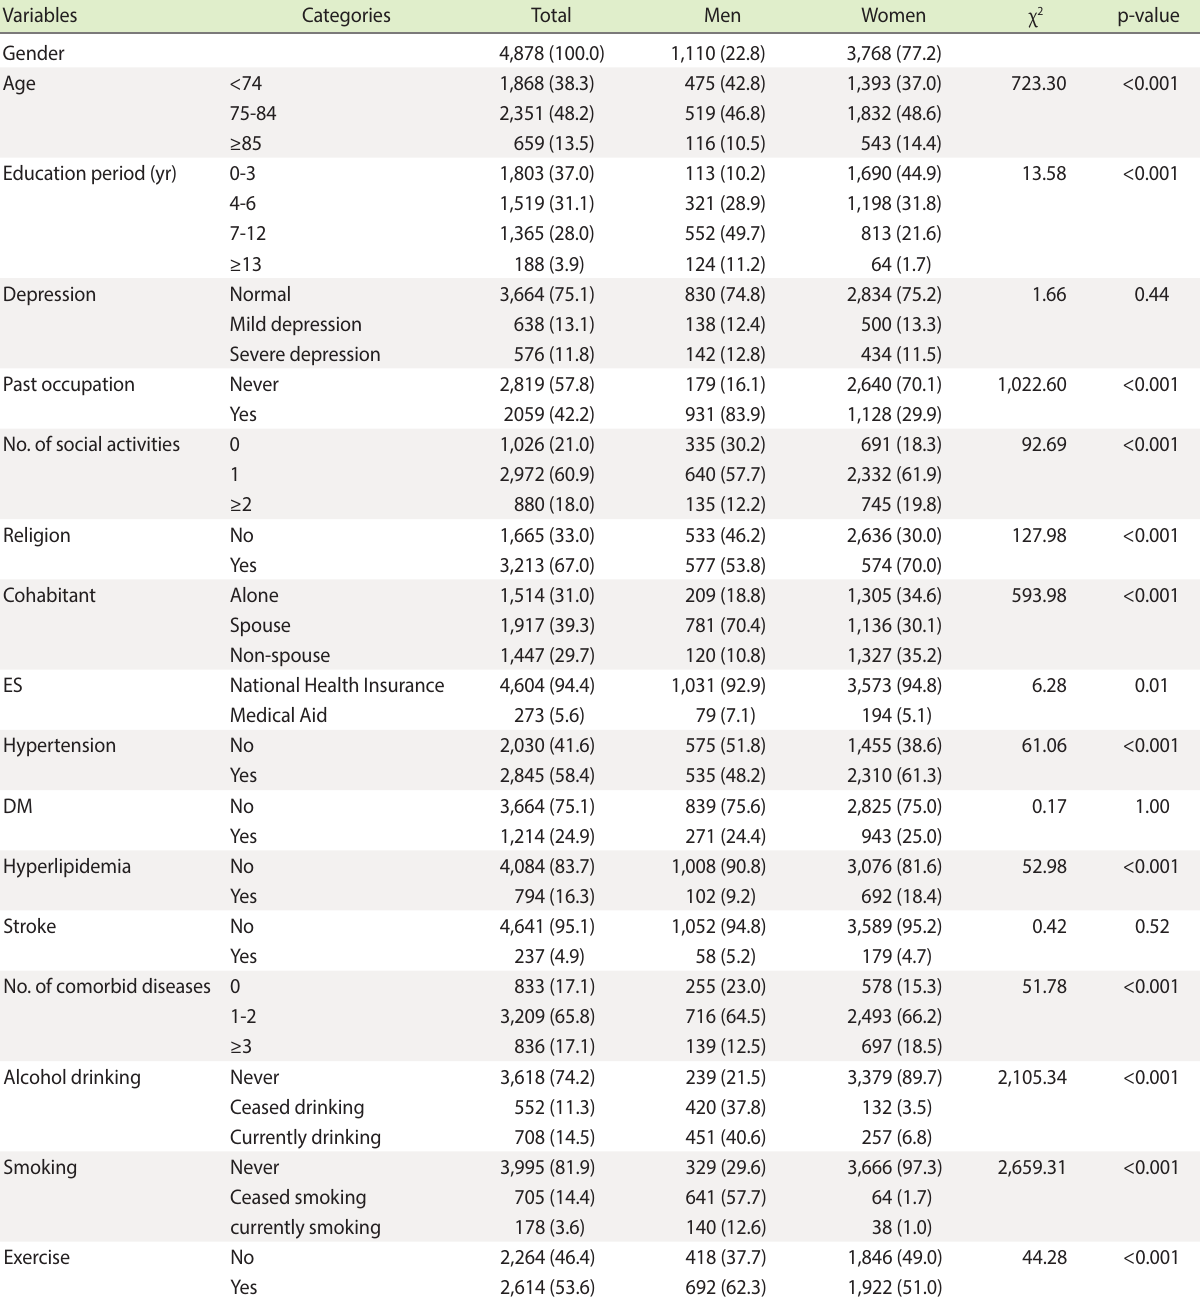
Table 1. Distribution of cognitive-related variables by gender